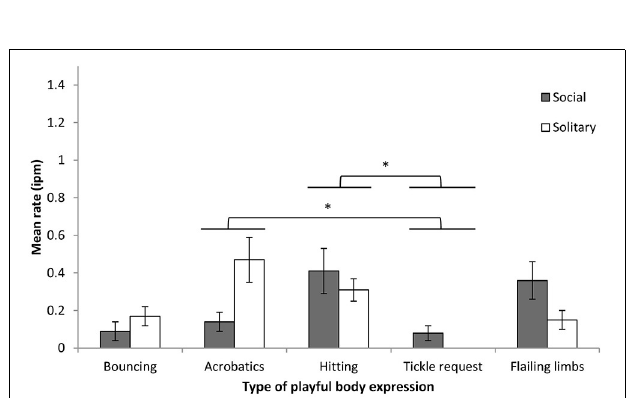
FIGURE 1 | Mean rate (intervals per minute of play, with SE) of chimpanzee infants’ playful expressions, as a function of modality of expression and type of play. The modality × play type interaction was examined by comparing playful expression rates for each modality across social and solitary play contexts (paired t -tests) and by comparing the playful expression rates for each modality within each play context (One-Way ANOVA with simple contrasts). ∗ p < 0 . 05, ∗∗ p < 0 . 01, ∗∗∗ p < 0 . 001.